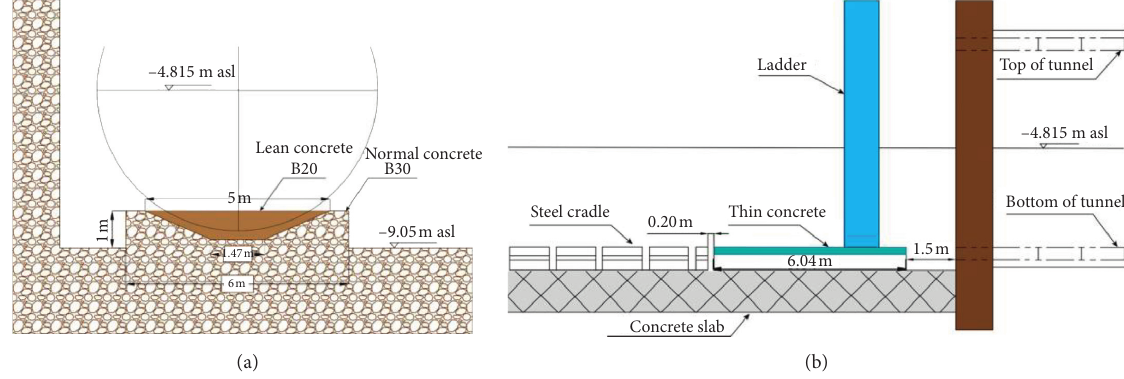
Figure 8: Design of the concrete cradle: (a) front view of the cradle and (b) side view of the